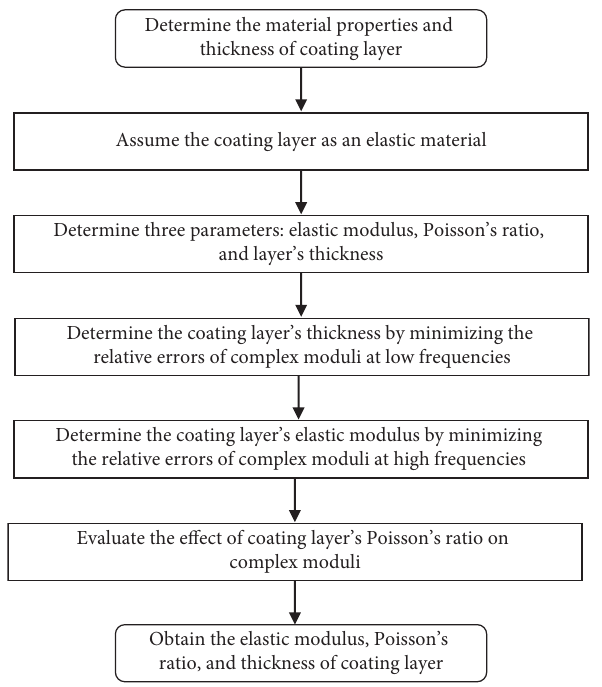
Figure 7: Flowchart of coating layer characterization